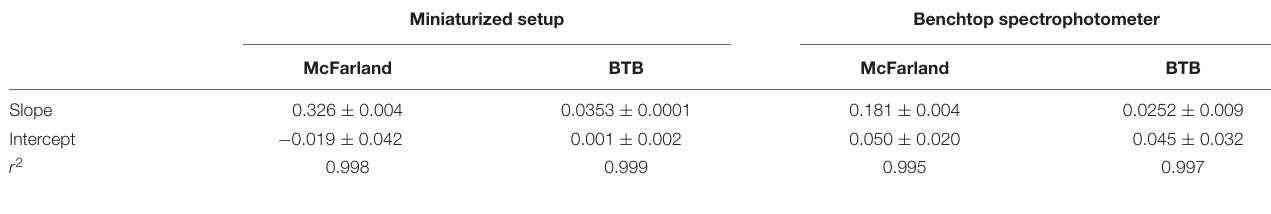
TABLE 1 | Parameters of the calibration curves for McFarland and bromothymol blue (BTB) standards obtained using the miniaturized setup (miniaturized spectrophotometer) and benchtop UV-Vis